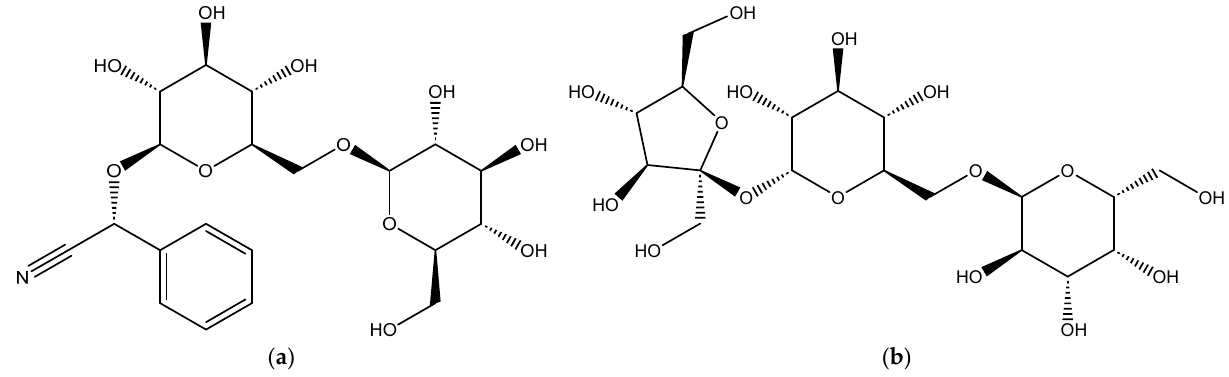
Figure 1. Chemical structures of amygdalin and raffinose compounds, ( a ) Amygdalin (Amy), and ( b ) Raffinose (Raf).